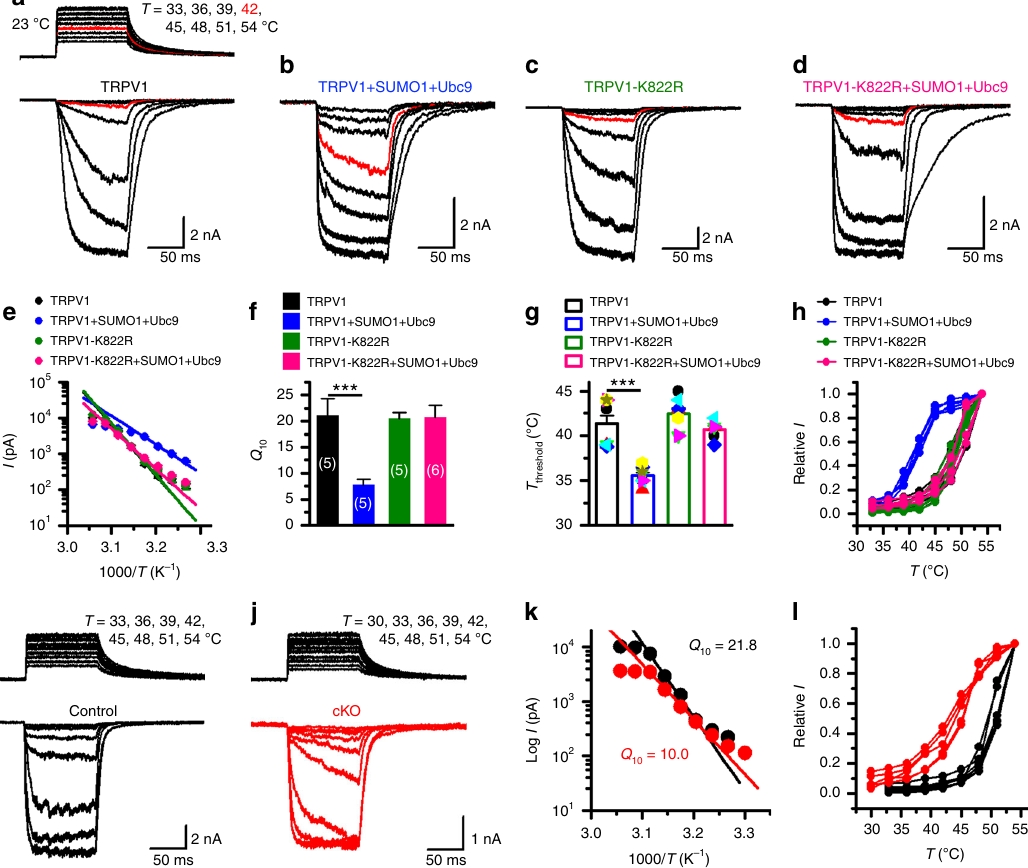
Fig. 7 SUMOylation lowered temperature coef fi cient ( Q 10 ) and temperature threshold ( T threshold ) of TRPV1 activation. a – d Representative responses to a family of temperature jumps ranging from 33 to 54 °C (see inset in a for an example) for CHO-K1 cells that expressed Flag-TRPV1 ( a ), Flag-TRPV1 + GFP- SUMO1 + Ubc9 ( b ), Flag-TRPV1-K822R ( c ), and Flag-TRPV1-K822R + GFP-SUMO1 + Ubc9 ( d ). Temperature was calibrated of fl ine from the pipette current using the temperature dependence of electrolyte conductivity. The red traces indicate the response at 42 °C. e Arrhenius plot of steady-state currents shown in a – d . The major component of the re fl ection that represents the strong temperature dependence was fi tted to a linear equation. Error bars indicate standard deviations (s.d.). f , g Comparison of Q 10 derived from the linear fi ts in e and T threshold changes. Q 10 = 21.0 ± 3.3 ( n = 5) and T threshold = 41.4 ± 0.9 ( n = 8) for TRPV1, Q 10 = 7.8 ± 1.0 ( n = 5) and T threshold = 35.6 ± 2.6 ( n = 8) for TRPV1 + SUMO1 + Ubc9, Q 10 = 20.5 ± 1.2 ( n = 5) and T threshold = 42.4 ± 0.7 ( n = 7) for TRPV1-K822R, Q 10 = 20.7 ± 2.3 ( n = 6) and T threshold = 40.7± 0.4 ( n = 6) for TRPV1-K822R + SUMO1 + Ubc9. Colored symbols in g indicate individual data points. Data are means ± s.e.m. P = 0.0004 for Q 10 TRPV1 vs. TRPV1 + SUMO1 + Ubc9; P = 0.00004 for T threshold TRPV1 vs. TRPV1 + SUMO1 + Ubc9 by Student ’ s t test. h Temperature response curves for TRPV1 (black), TRPV1 + SUMO1 + Ubc9 (blue), TRPV1-K822R (olive), and TRPV1-K822R + SUMO1 + Ubc9 (pink), measured from the maximal currents at the end of temperature steps. Each curve represents measurements from an individual cell and the responses were normalized to its maximum responses at 54 °C. i , j Representative whole-cell current traces evoked by a family of temperature jumps in DRG neurons isolated from control and SENP1 cKO mice. Holding potential was − 60 mV. k Arrhenius plots for cells shown in i , j . Heat-evoked responses were fi tted by linear regression and yielded Q 10 = 21.8 for control (black, n = 6) and Q 10 = 10.0 for SENP1 cKO (red, n = 5). l Comparison of temperature response curves of control (black) and SENP1 cKO (red) DRG (Fig. 6k, inset), which evoked non-inactivating ionic currents at voltages >0 mV for all cells (Fig. 6k – n). The current at the end of the 200 ms pulse was converted to conductance and normalized to that obtained at 200 mV before fi tting with the Boltzmann function, which yielded similar conductance – voltage ( G – V ) relationships for both TRPV1 constructs no matter if SUMO1 was present or not (Fig. 6o). These indicate that neither the mutation nor co-expression of SUMO1 changed the voltage dependence of TRPV1 under basal conditions at the room temperature. Last, we tested if TRPV1 SUMOylation could affect the temperature response of the channel. Although temperature gating 42 , the large and quick changes in enthalpy and entropy